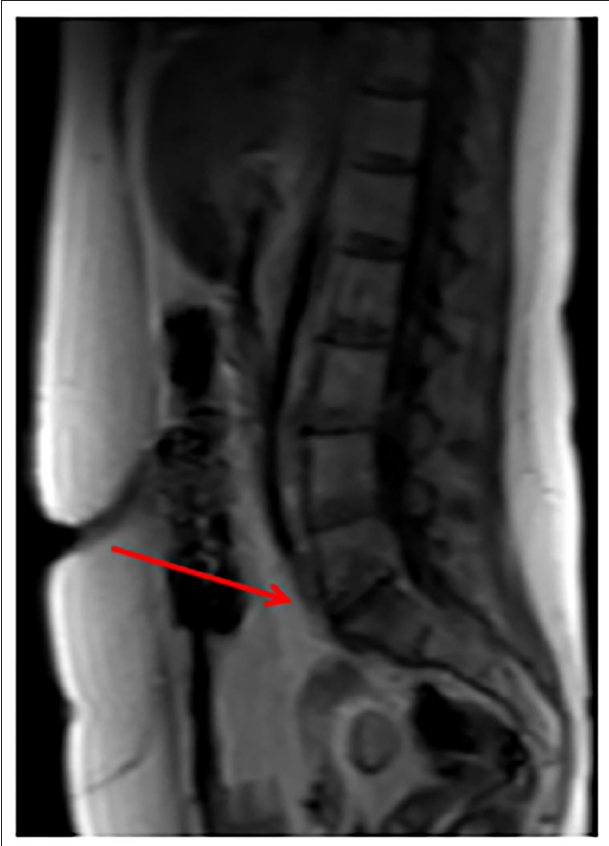
FIGURE 4 | Pelvic MRI 169 days after the second surgery showing a progressive decrease of the purulent collection and a spontaneous resolution of the